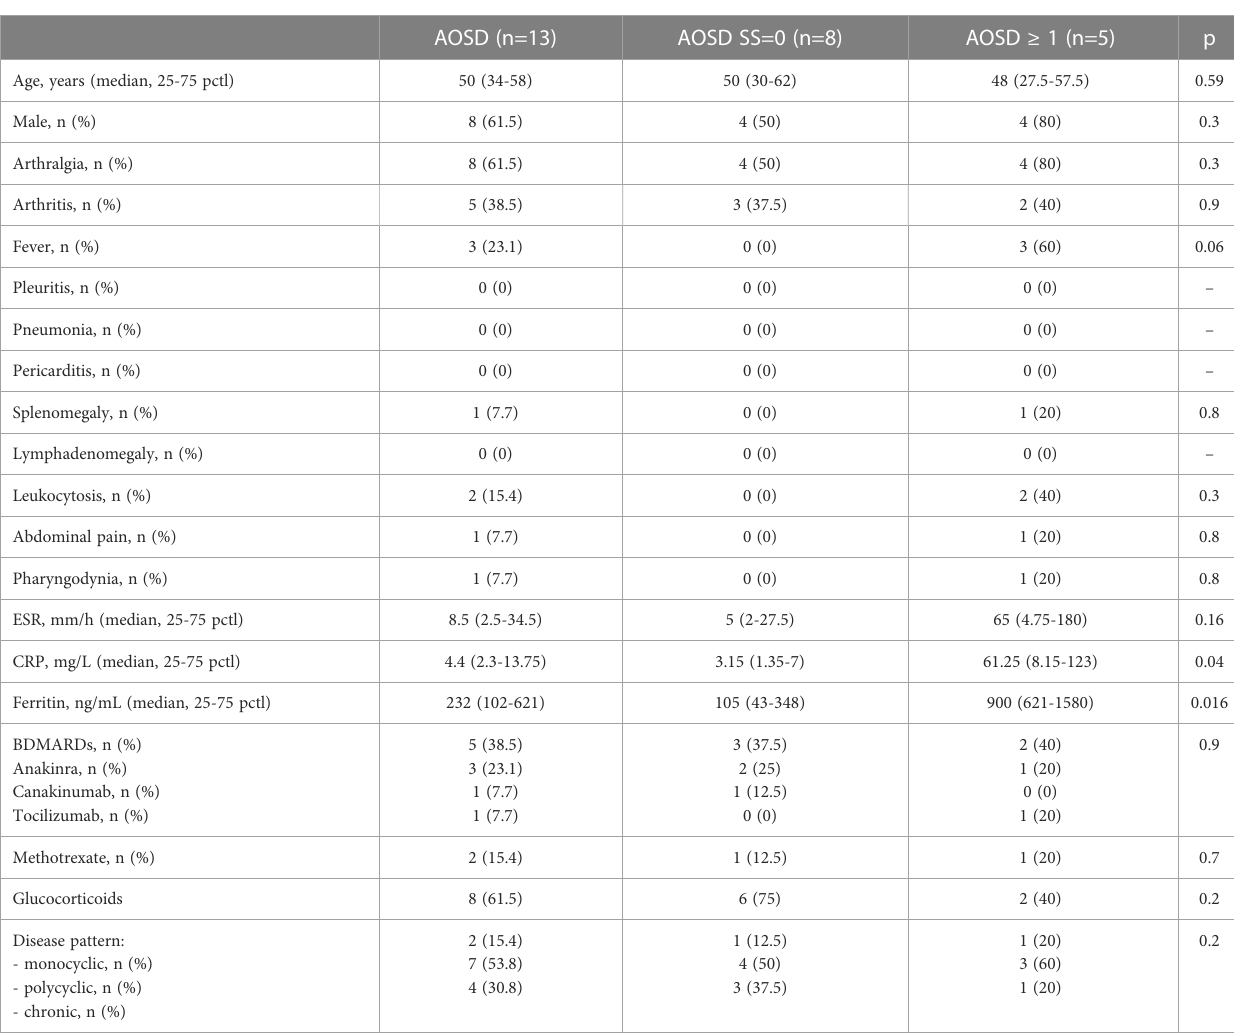
TABLE 2 AOSD patients